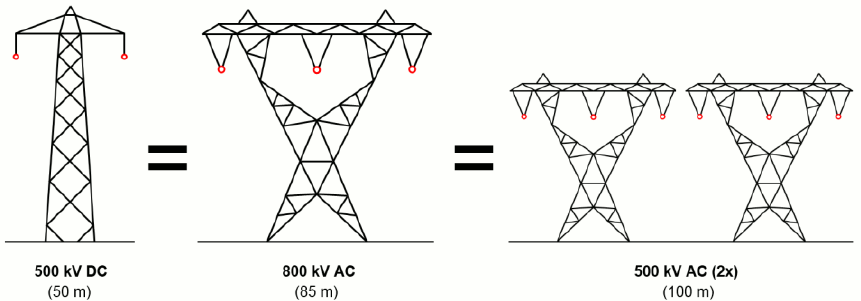
Figure 2. HVDC transmission line versus high-voltage alternating current (HVAC) transmission line.